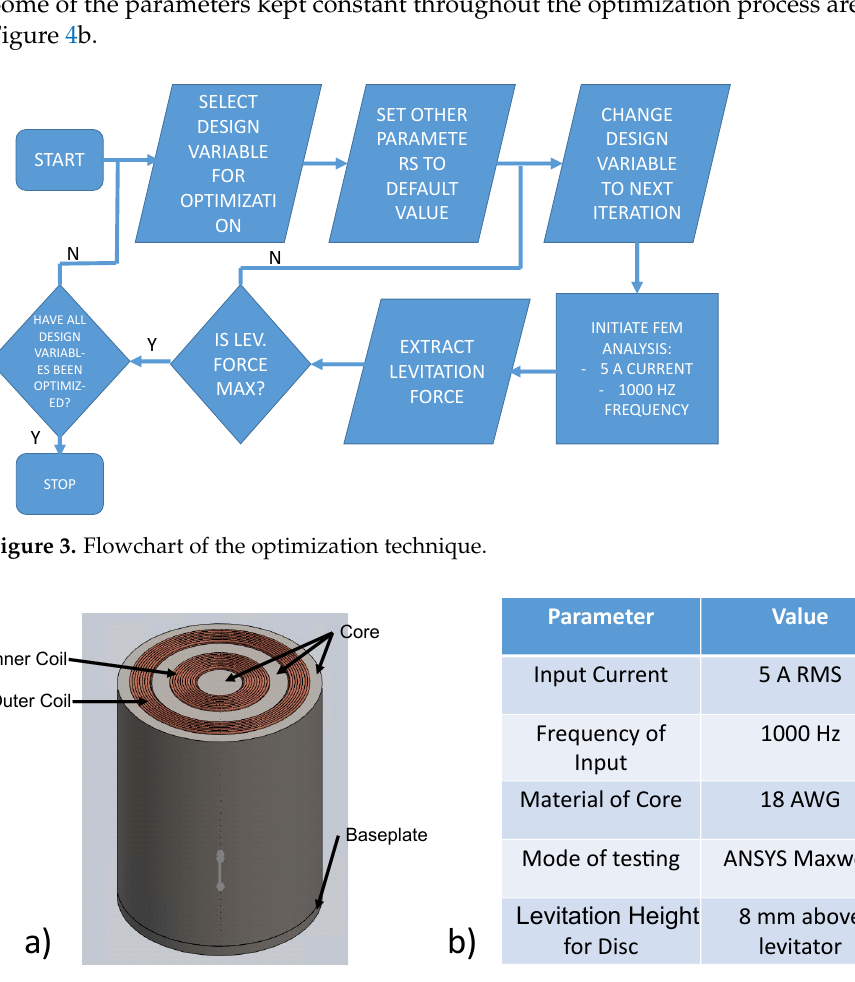
Figure 4. System components and parameters of micromanipulator levitation system. ( a ) CAD Model of the envisioned System. ( b ) Definition of constant parameters for